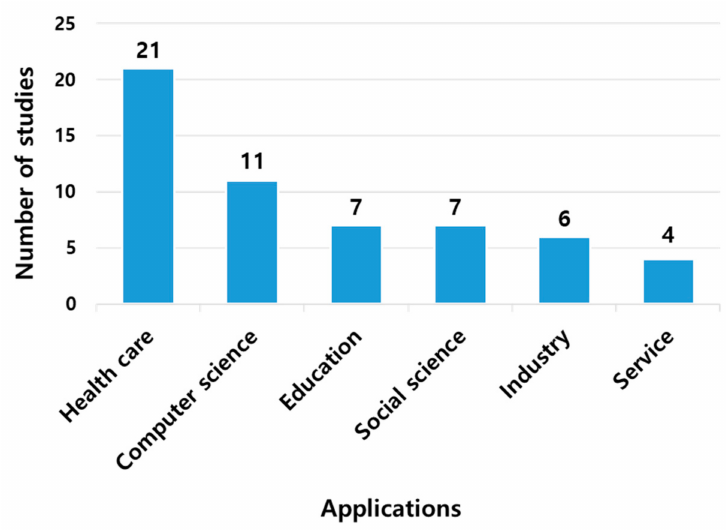
Figure 5. Number of studies based on a study of the application fields.